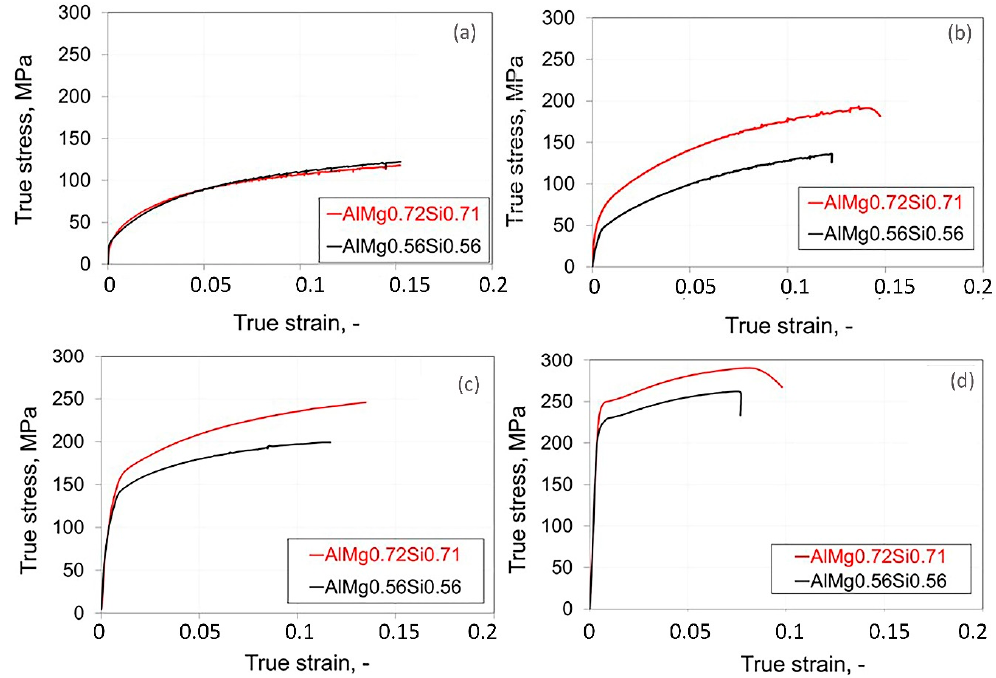
Figure 3. True stress and true strain curves of Al-Mg-Si wire rods with di ff erent amounts of Mg and Si after homogenization ( a ), supersaturation ( b ), natural aging ( c ) and artificial aging ( d ). Figures 4 and 5 present the microstructure results of the wire rods after homogenization.